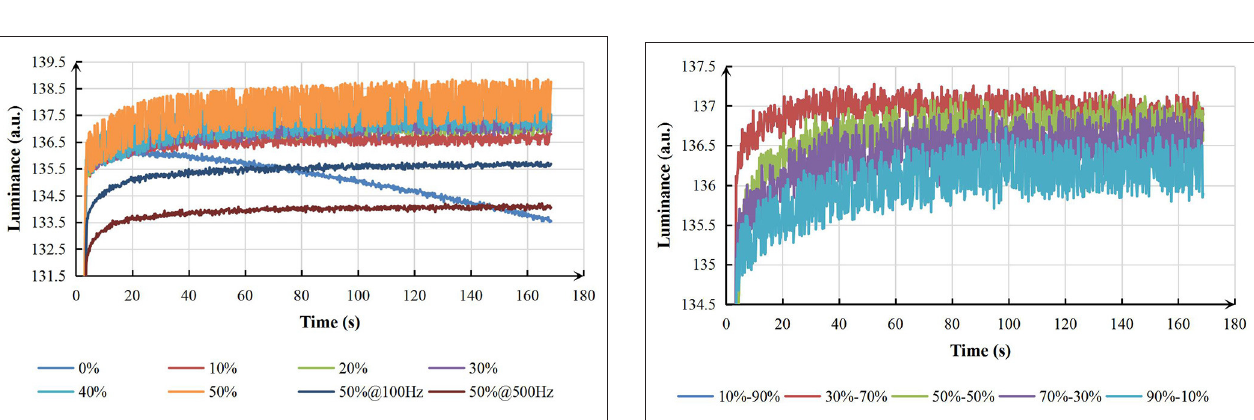
FIGURE 10 | The brightness curve of an EWD driven by reset signals with different proportions P reset (F = 50Hz, V Release = − 30V, V max = 30V, t 1 = t 2 .).